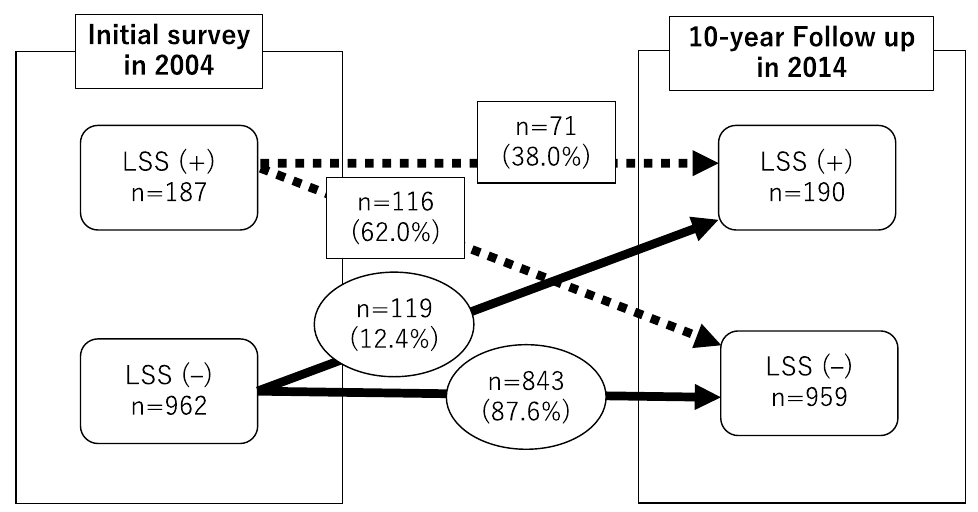
Figure 2. The number of LSS (+) and (−) cases in 2004 and 2014 and the time course of LSS. LSS, lumbar spinal stenosis.